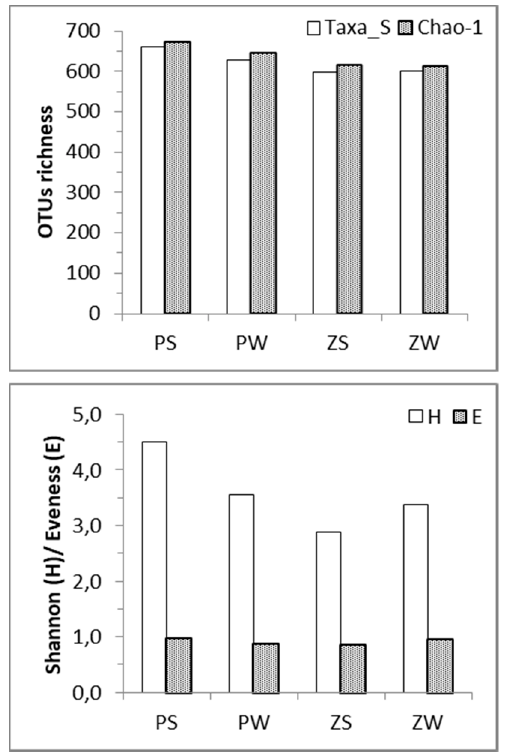
Figure 2. Top : Observed and estimated (Chao1) OTUs richness. Bottom : diversity (Shannon, H) and evenness (Simpson 1-D, E) indices in the two sampling sites (P,Z) and seasons (S,W).